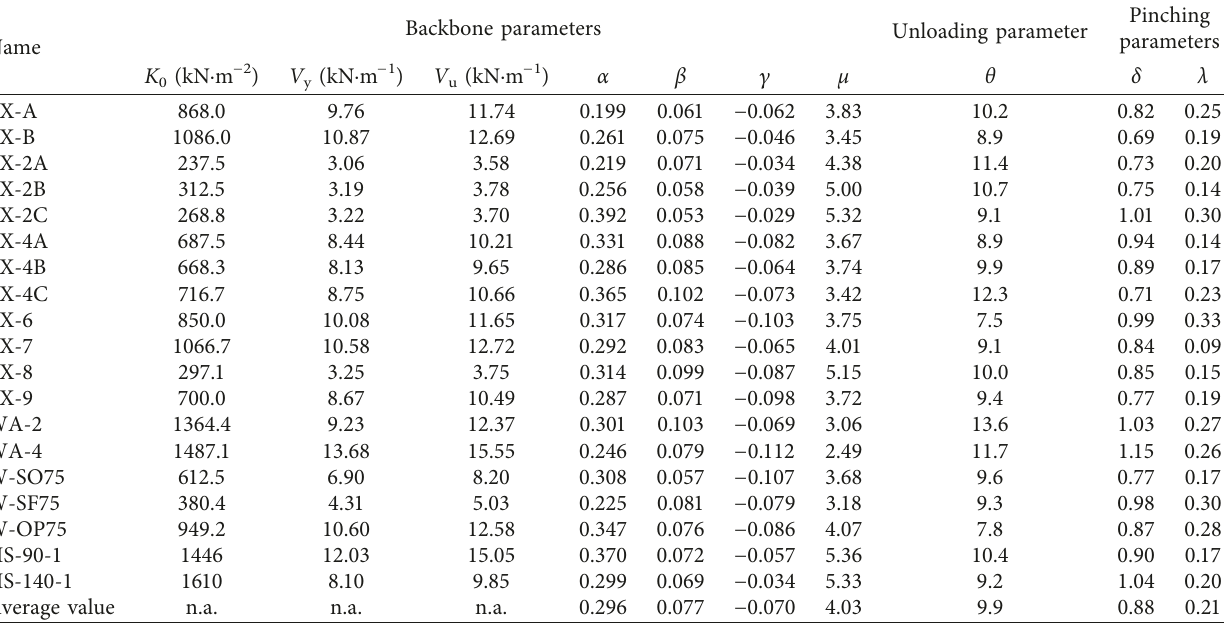
Figure 6: Hysteretic model: (a) backbone rule, (b) unloading rule, and (c) pinching rule. Table 3: Hysteretic parameters of